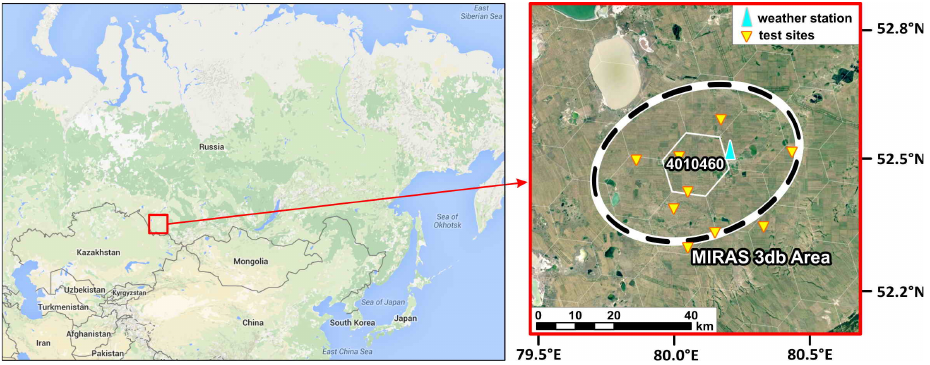
Figure 1. A map of the study area with a test site (SMOS pixel).